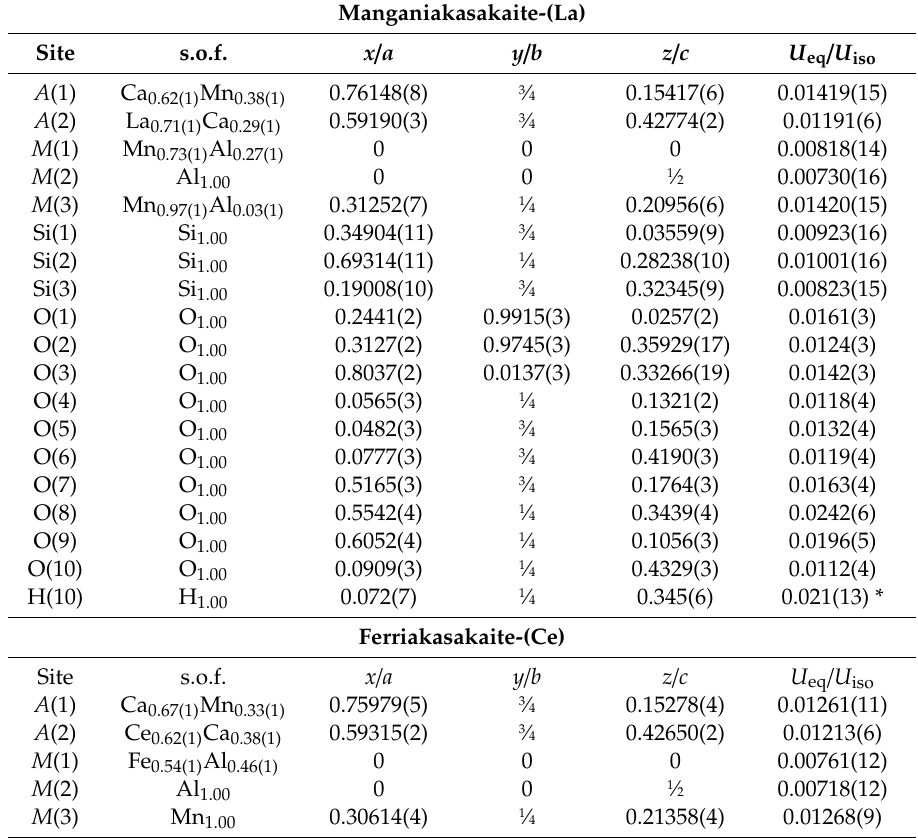
Table 5. Fractional atomic coordinates, site occupation factors (s.o.f.) and isotropic (*) or equivalent isotropic displacement parameters (Å 2 ) for manganiakasakaite-(La) and